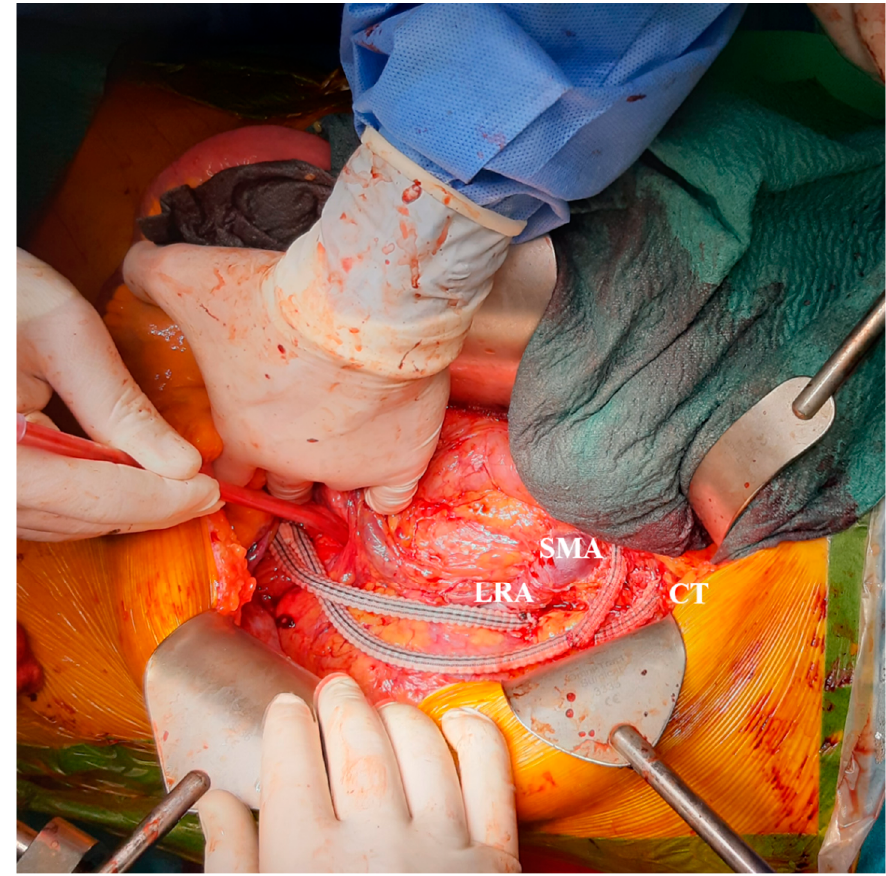
Figure 3. Intraoperative image showing the visceral debranching graft with its three branches supplying the left renal artery (LRA), the superior mesenteric artery (SMA), and the celiac trunk (CT).